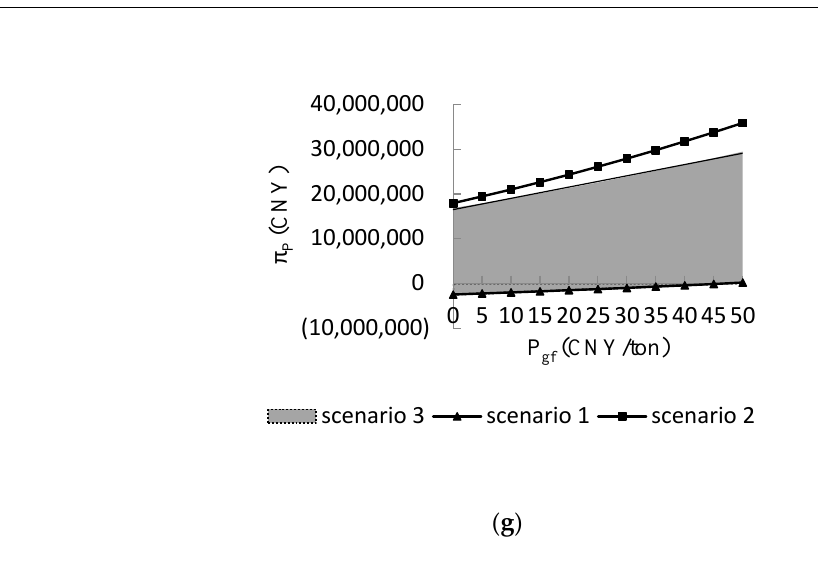
Figure 3. Effect of government incentives on equilibrium solutions in three game models. ( a ) Represent the optimal decision strategies of Q 1 under government incentive for farmer; ( b ) Represent the optimal decision strategies of P 1 under government incentive for farmer; ( c ) Represent the optimal decision strategies of P 1 under government incentive for broker; ( d ) Represent the optimal decision strategies of P 2 under government incentive for farmer; ( e ) Represent the optimal profits of µ F under government incentive for farmer; ( f ) Represent the optimal profits of π B under government incentive for farmer; ( g ) Represent the optimal profits of π P under government incentive for farmer.